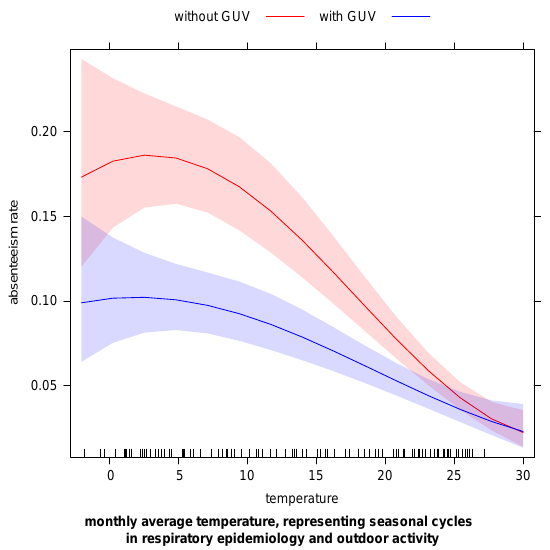
Figure 4. Solid lines show model-estimated monthly child absenteeism rates from preschool due to respiratory illness before and after upper room GUV was installed. Shaded regions are 95% pointwise confidence bands for each estimate. Red represents the months prior to GUV, while blue represents months with GUV. The effect varies by monthly average temperature (used as a proxy for seasonal cycles in respiratory epidemiology and in child outdoor activity), but GUV reduces predicted absenteeism by nearly half at all but the highest summer temperatures.